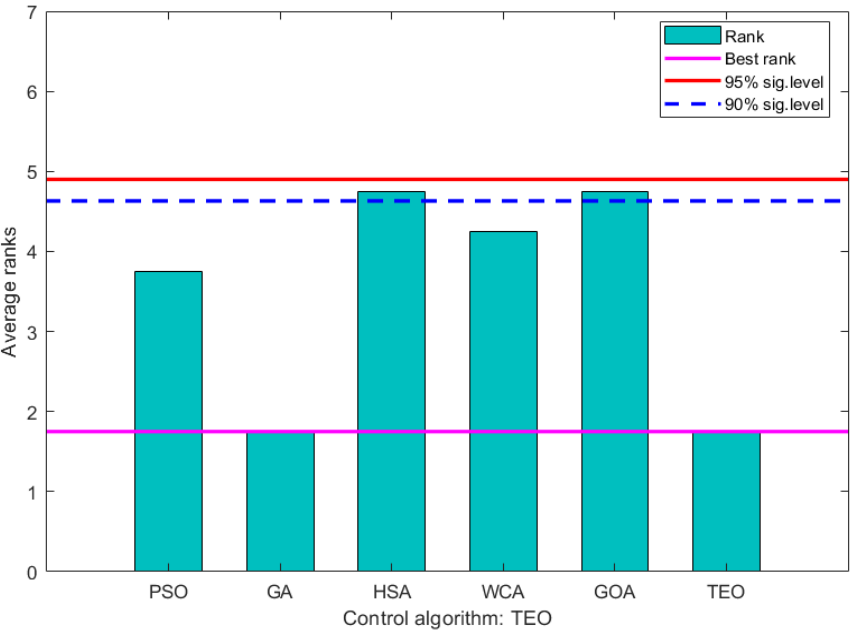
Figure 6. Graphical representation of the Bonferroni-Dunn’s test for problem (35).